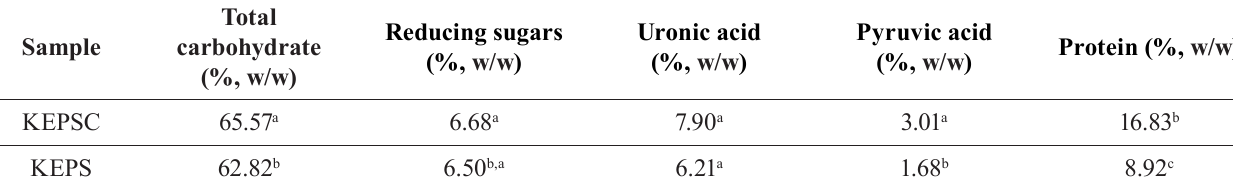
TABLE I - T otal carbohydrate, reducing sugars, uronic acid, pyruvic acid, and protein content of exopolysaccharides from K. oxytoca